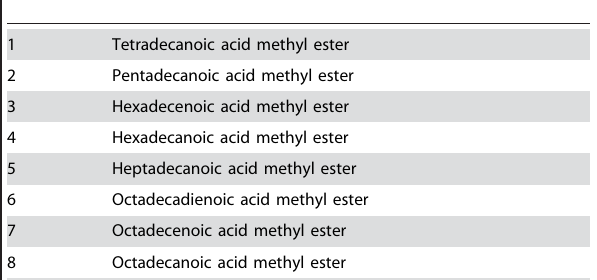
Table 1. Alkaline methanolysis reaction produced various fatty acid methyl esters which are typical components of biodiesel *